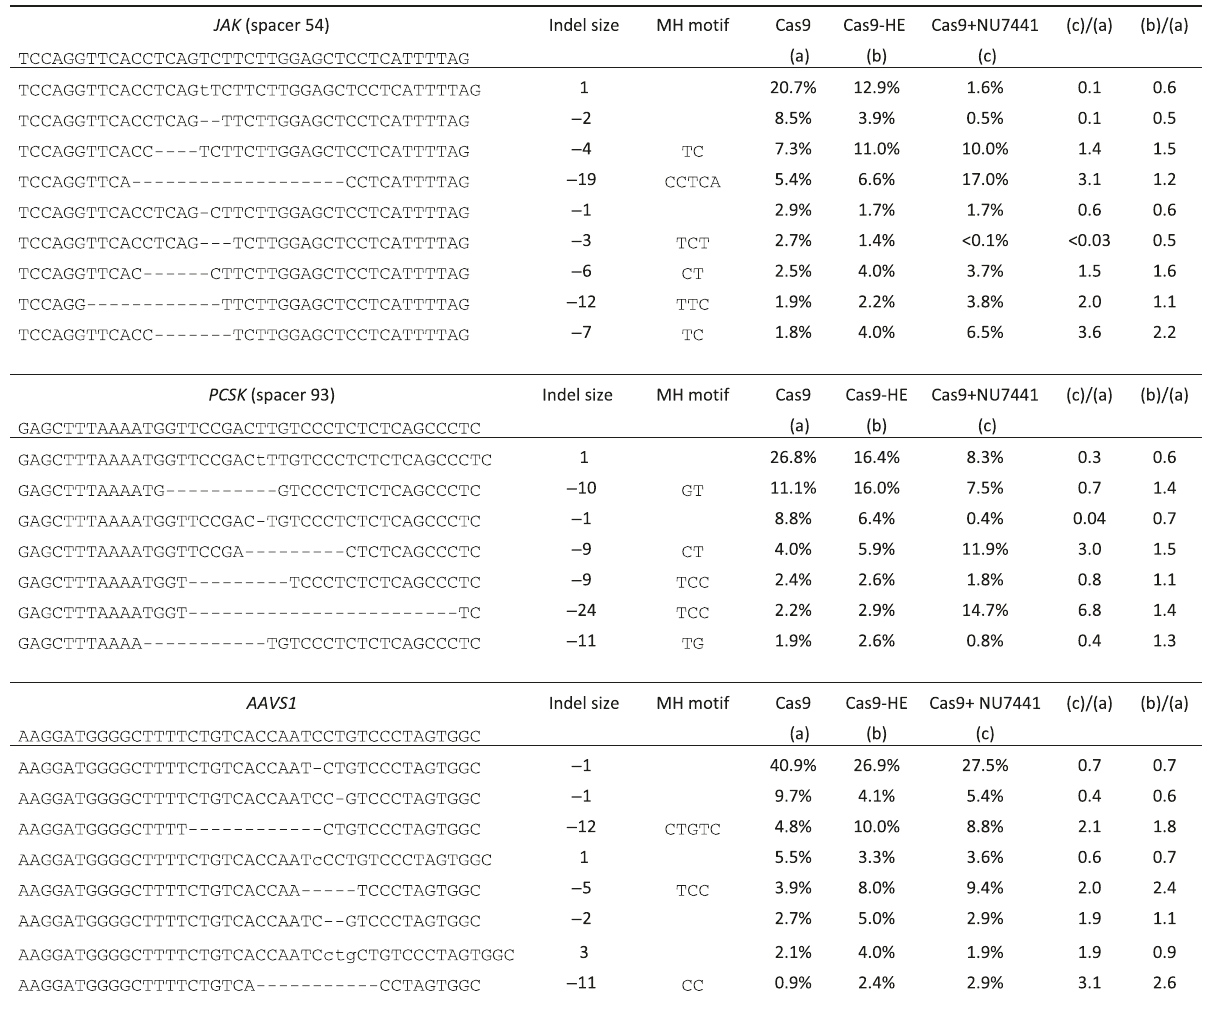
Table 1 Indel mutation patterns induced by Cas9, Cas9 – HE, and Cas9 +